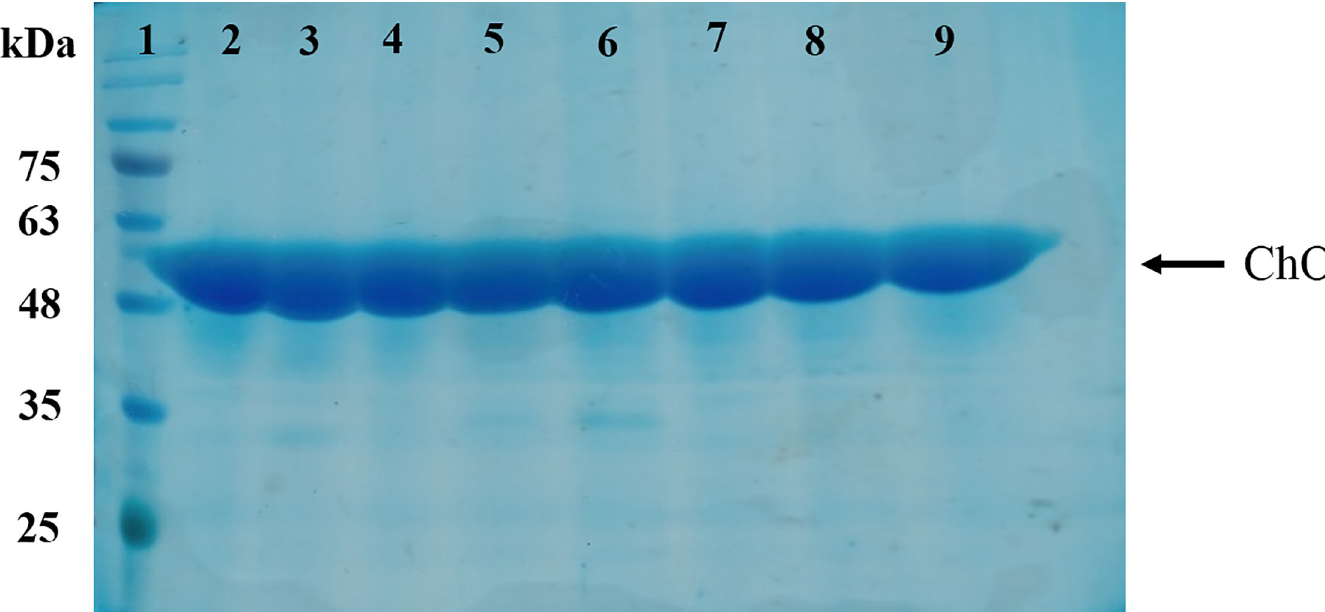
Fig 6. SDS-PAGE analysis of purified recombinant cholesterol oxidase. The quality of the eluted pure recombinant ChO was analyzed using SDS-PAGE 10%. Lane 1: Protein marker; Lanes 2–9: Fractionated samples eluted from Ni-CAM column by 150 mM imidazole.